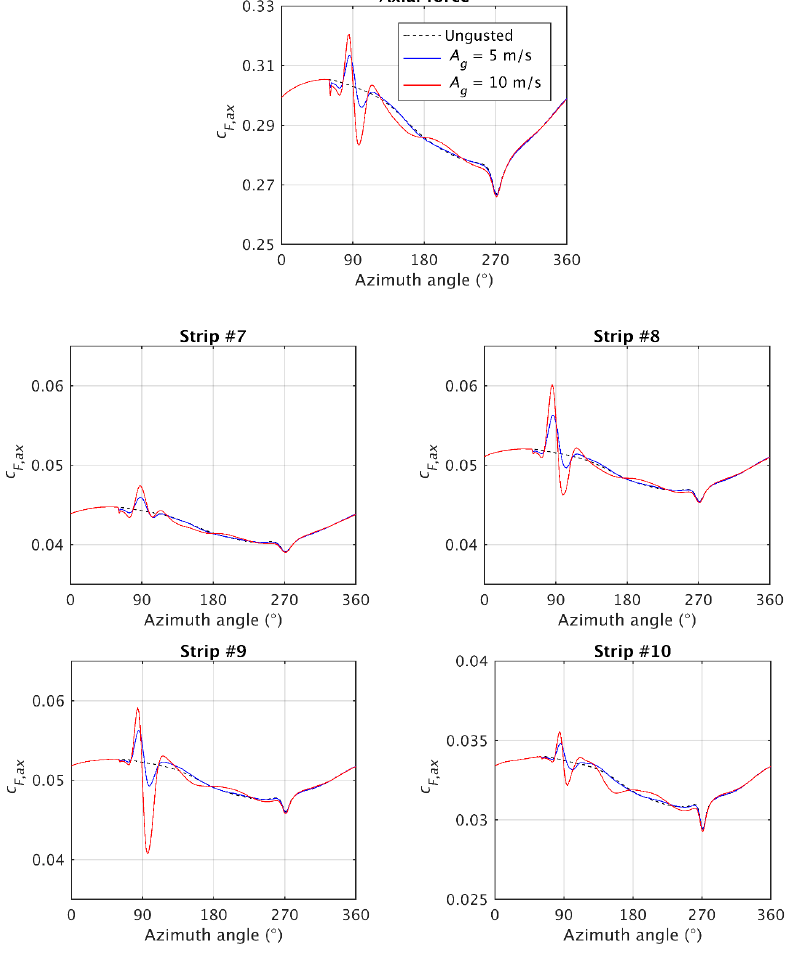
Figure 13. The 1 + cos gusts: ( top ) total aerodynamic axial force over the blade hit by the gust as a function of its azimuth angle and ( bottom ) axial force contribution of the four most outboard strips.